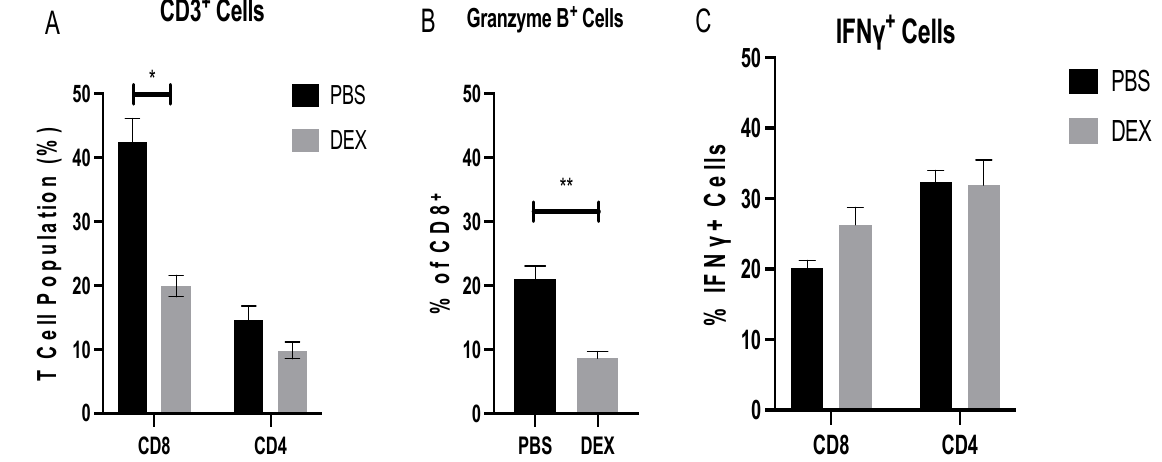
Figure 5. BAL T cell response during IBV infection. BAL T cells from mice treated with PBS or 10 mg/kg DEX and infected with 10 3 PFU IBV were collected on day 8 pi and analyzed by flow cytometry. ( A ) Extracellular surface staining to determine percentages of CD8 + and CD4 + cells of CD3 + gated lymphocytes. A portion of BAL cells was stimulated with PMA/Ionomycin as described in materials and methods, and functional analyses of cytokine production were determined for ( B ) granzyme B and ( C ) IFN γ . Bars represent the mean +/ − SEM, * p < 0.05, ** p < 0.01 by multiple Mann–Whitney U test.